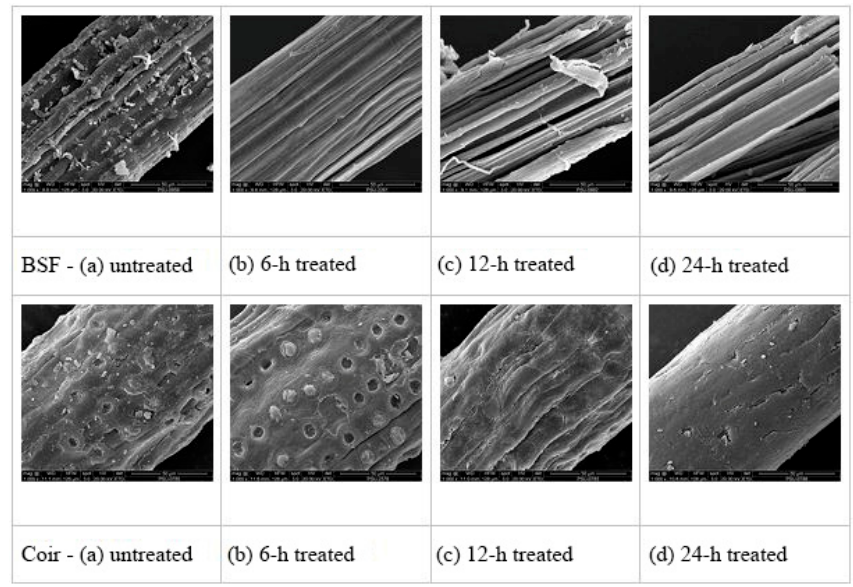
Figure 3. SEM micrographs (at 1000×) of BSF and coir: ( a ) untreated, ( b ) 6 h treated, ( c ) 12 h treated, and ( d ) 24 h treated. Table 2. Mechanical and physical properties of the